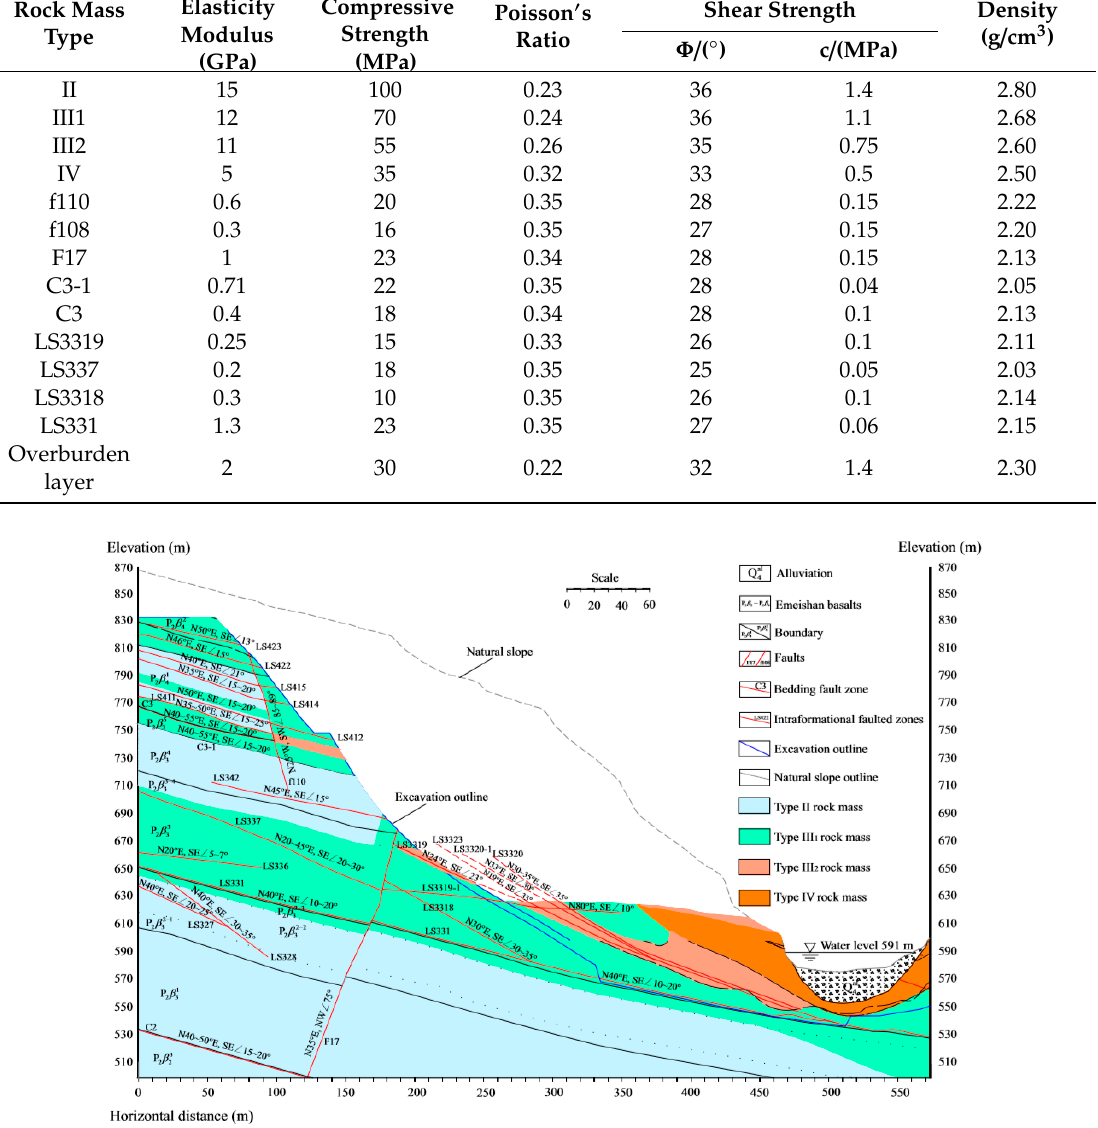
Figure 3. Geological cross-section of the left bank slope along the longitudinal axis of the arch dam after excavation to an elevation of 628 m [26] (Copyright © 2017, Springer Nature). Table 1. Characteristics of the interlayer zones.